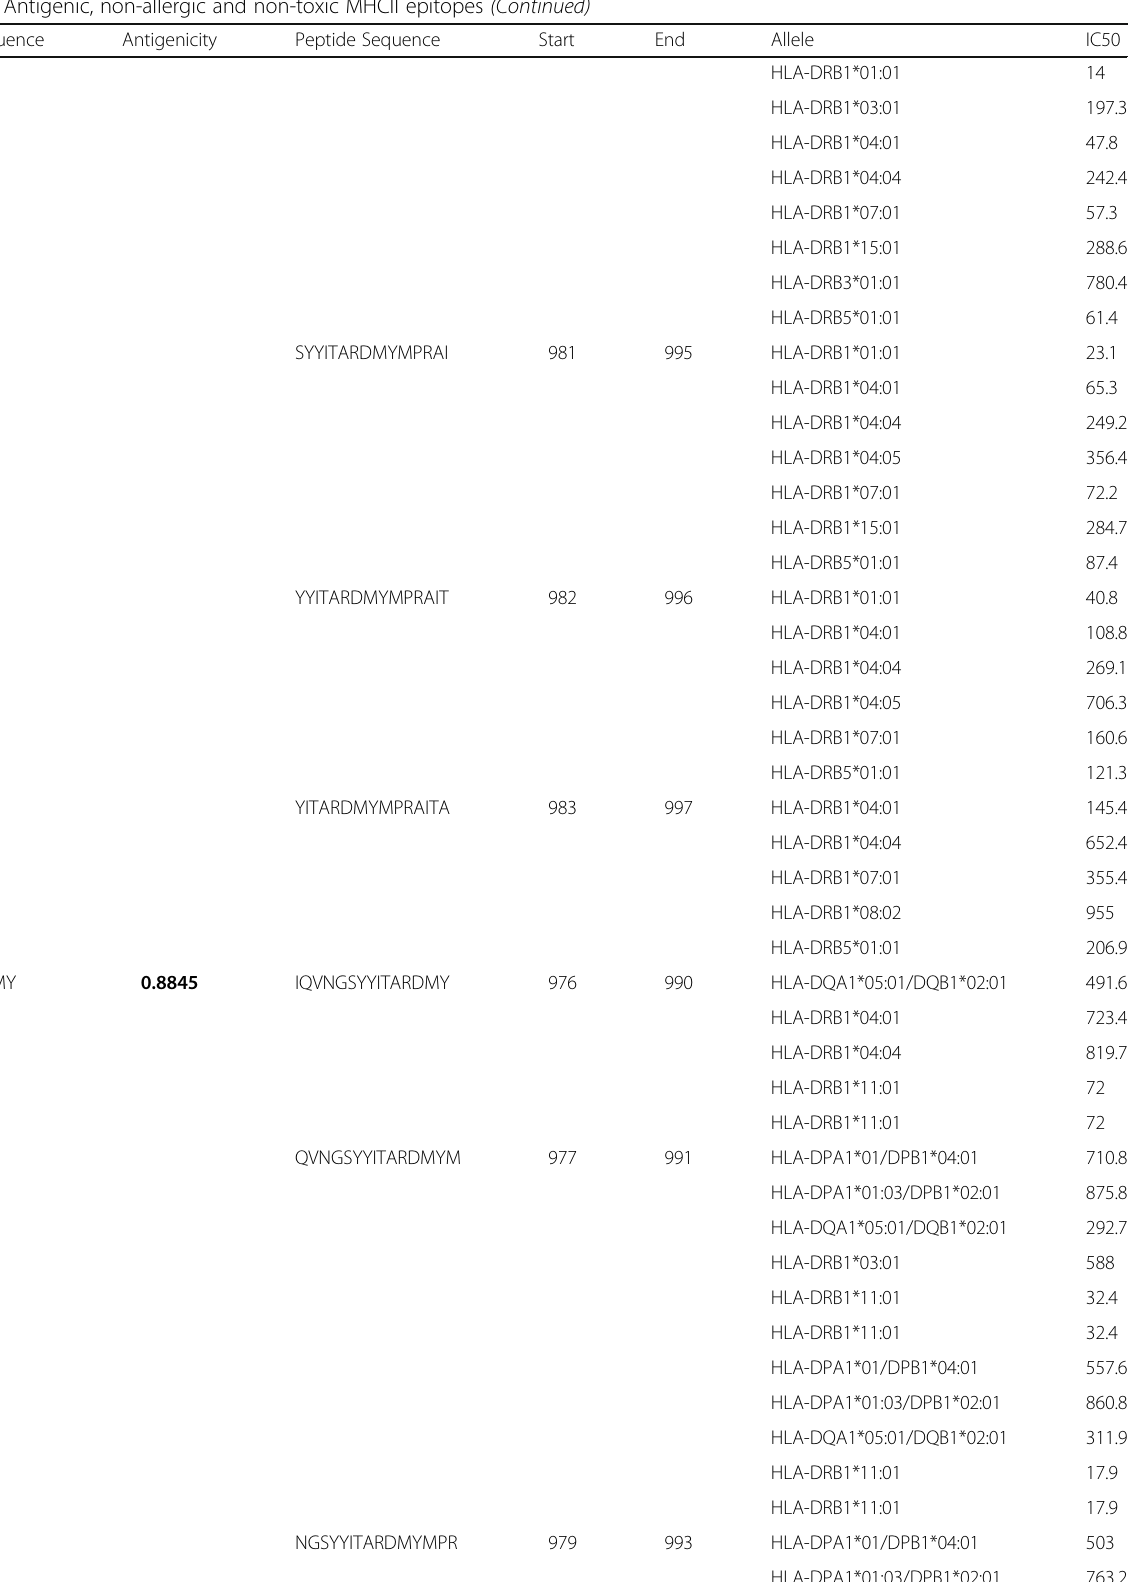
Table 7 Antigenic, non-allergic and non-toxic MHCII epitopes (Continued) Core